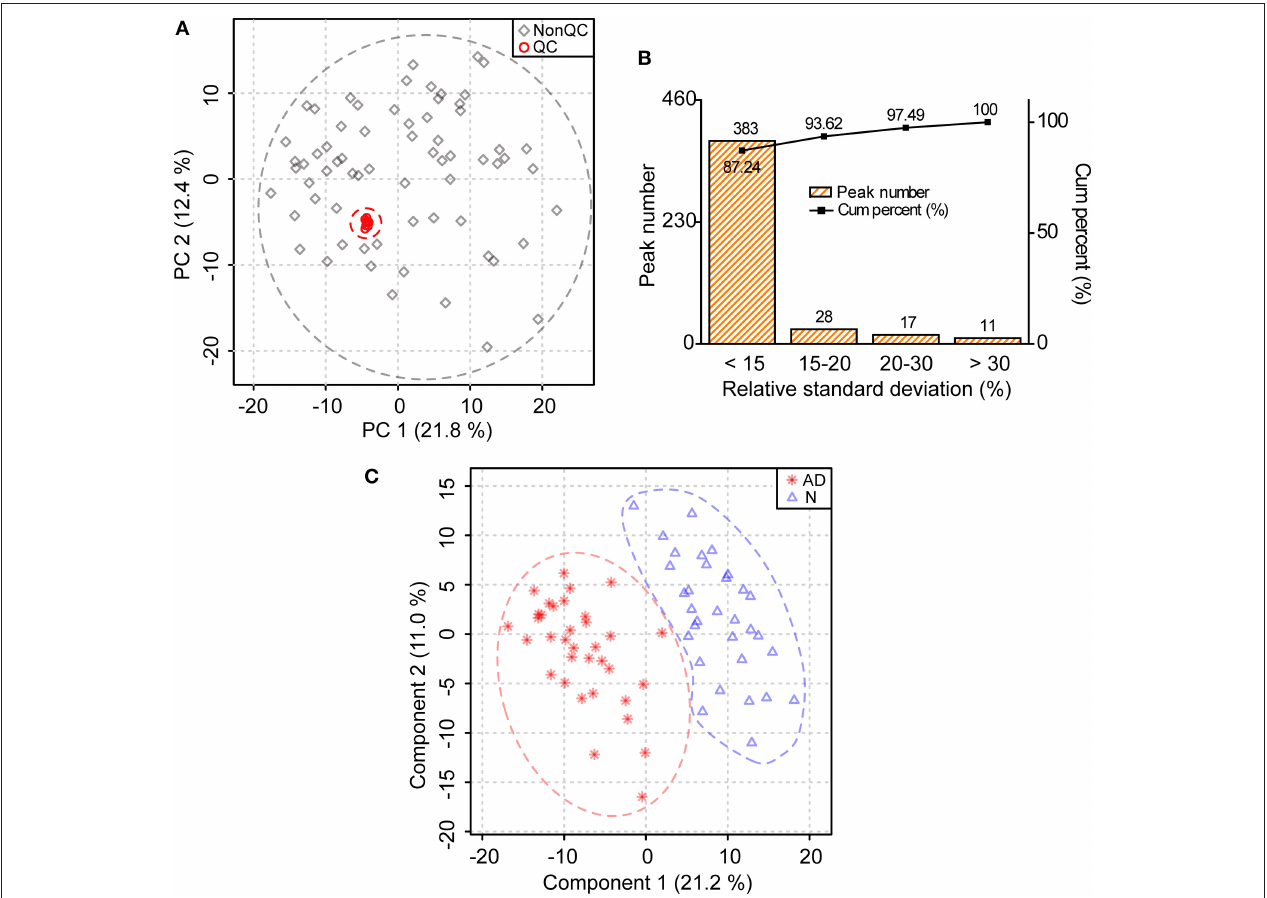
FIGURE 1 | Substantial changes in the lipid profile of patients with AD. (A) Distribution of quality control (QC) samples in the score plot of principal component analysis. The explained variances are provided in brackets. (B) Distribution of relative standard deviations of ions in QC samples. (C) Changes in the lipid profile of patients with AD in the score plot of partial least square discriminant analysis. The explained variances are provided in brackets. n = 32 and 35 in the normal (N) and AD group,